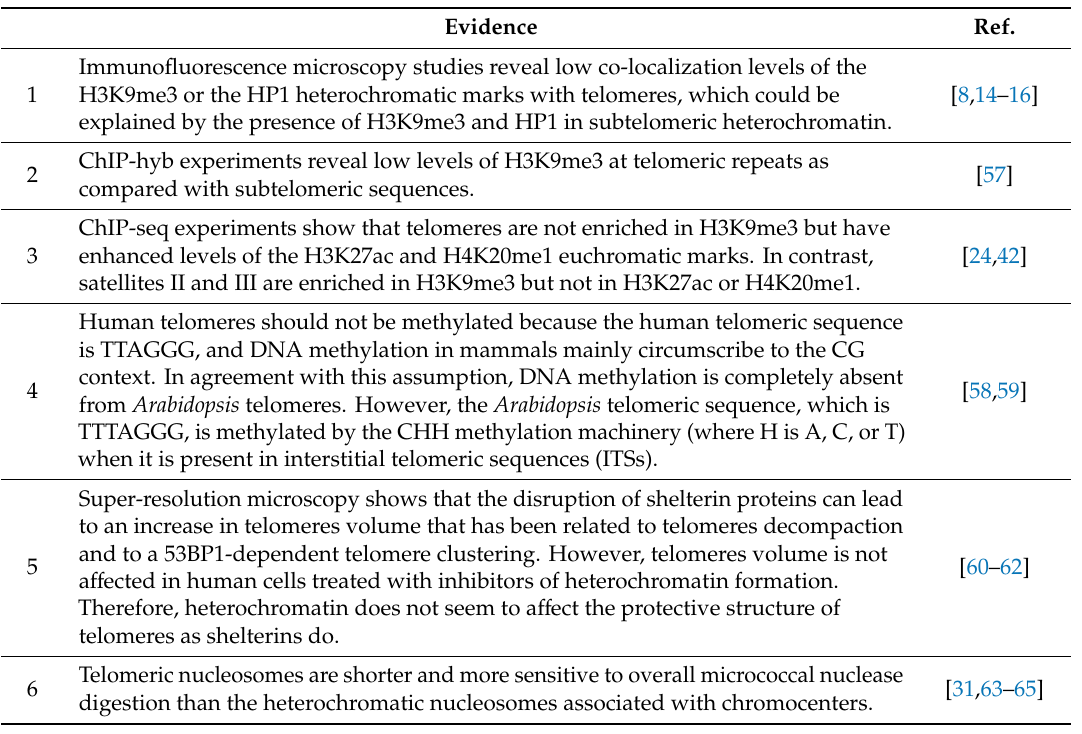
Table 1. Experimental evidence supporting that telomeres are not heterochromatic in most commonly studied [non-alternative lengthening of telomeres (ALT)] human cell lines. Evidence